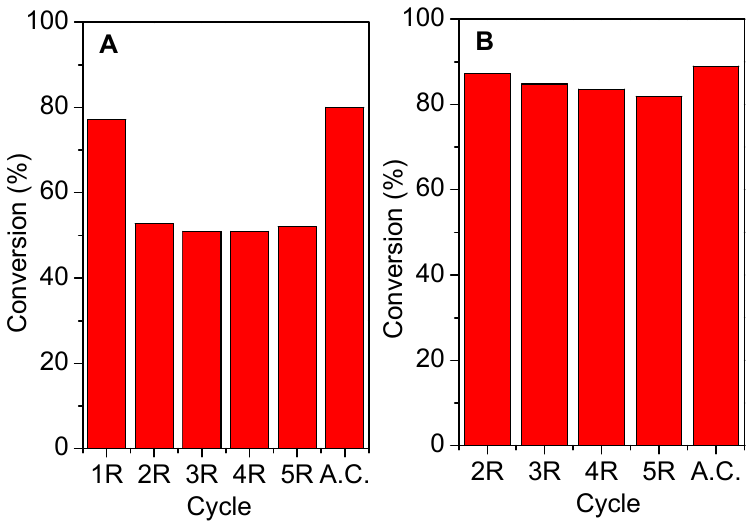
Figure 6. Reuses of the 30% FeMagN at 400 °C for both oxidation reactions at 25 °C, 1 atm. ( A ) Oxidation of isoeugenol; each cycle was 24 h of reaction; ( B ) oxidation of vanillyl alcohol; each cycle was 20 min of reaction. A.C.: reused catalyst after calcination.